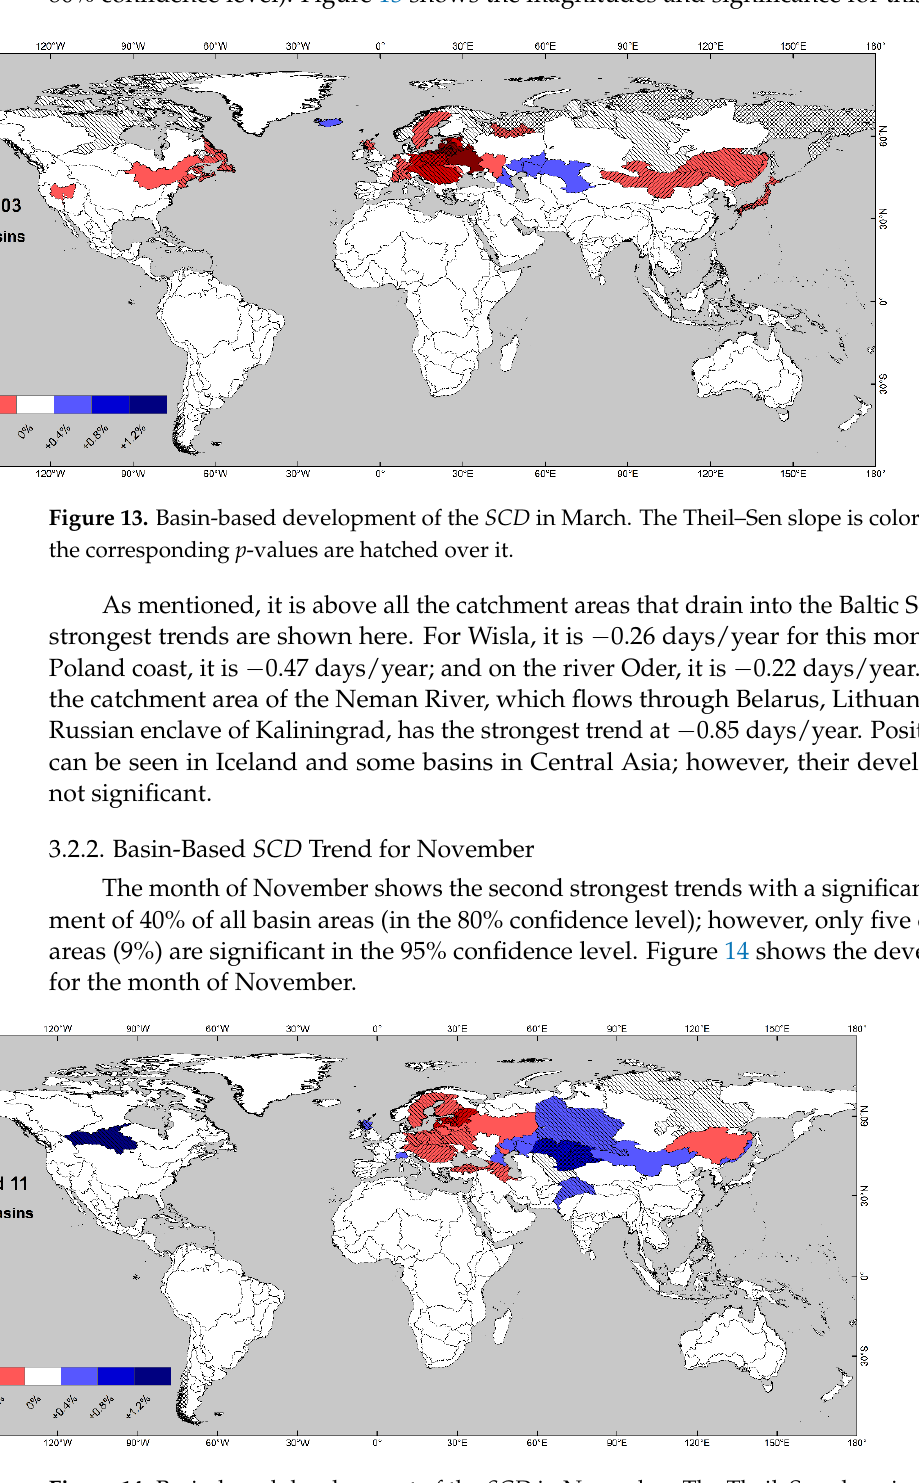
Figure 14. Basin-based development of the SCD in November. The Theil–Sen slope is color coded and the corresponding p -values are hatched over it.